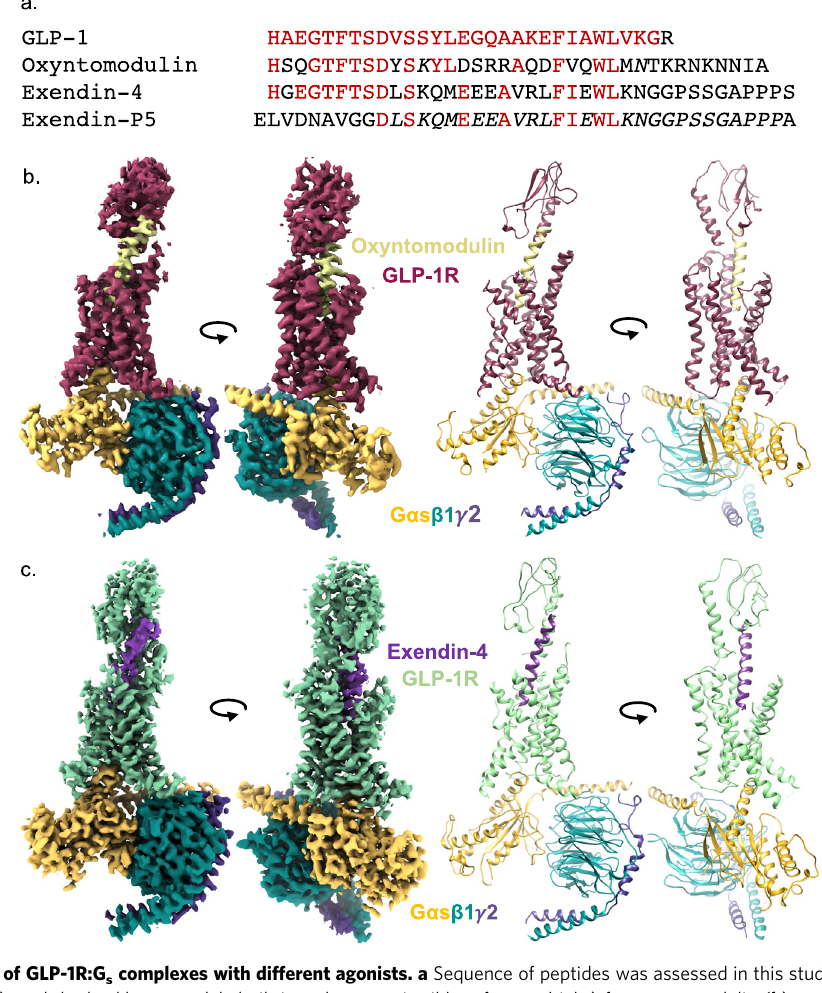
Fig. 1 Cryo-EM structures of GLP-1R:G s complexes with different agonists. a Sequence of peptides was assessed in this study. b and c orthogonal views of the cryo-EM maps (left), and the backbone models built into the maps in ribbon format (right) for oxyntomodulin ( b ) and exendin-4 ( c ) bound GLP- 1R:G s complexes. Colouring denotes the protein segments as highlighted on the fi gure